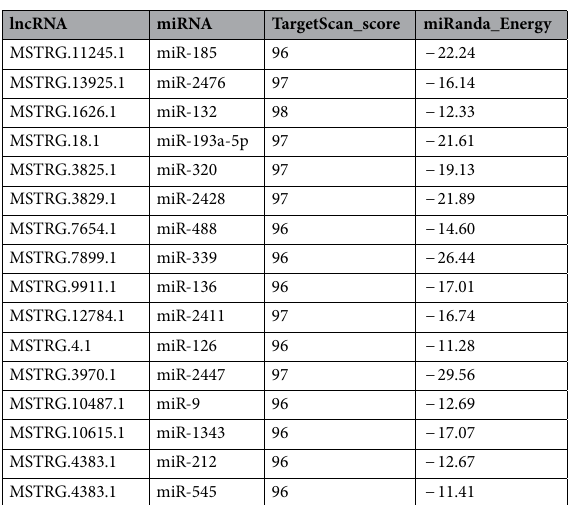
Table 3. Interaction versus between lncRNA–miRNA. Table shows that the num of TargetScan fractional percentiles ≥ 96, − 30 < the num of Miranda maximum free energy values < − 10.